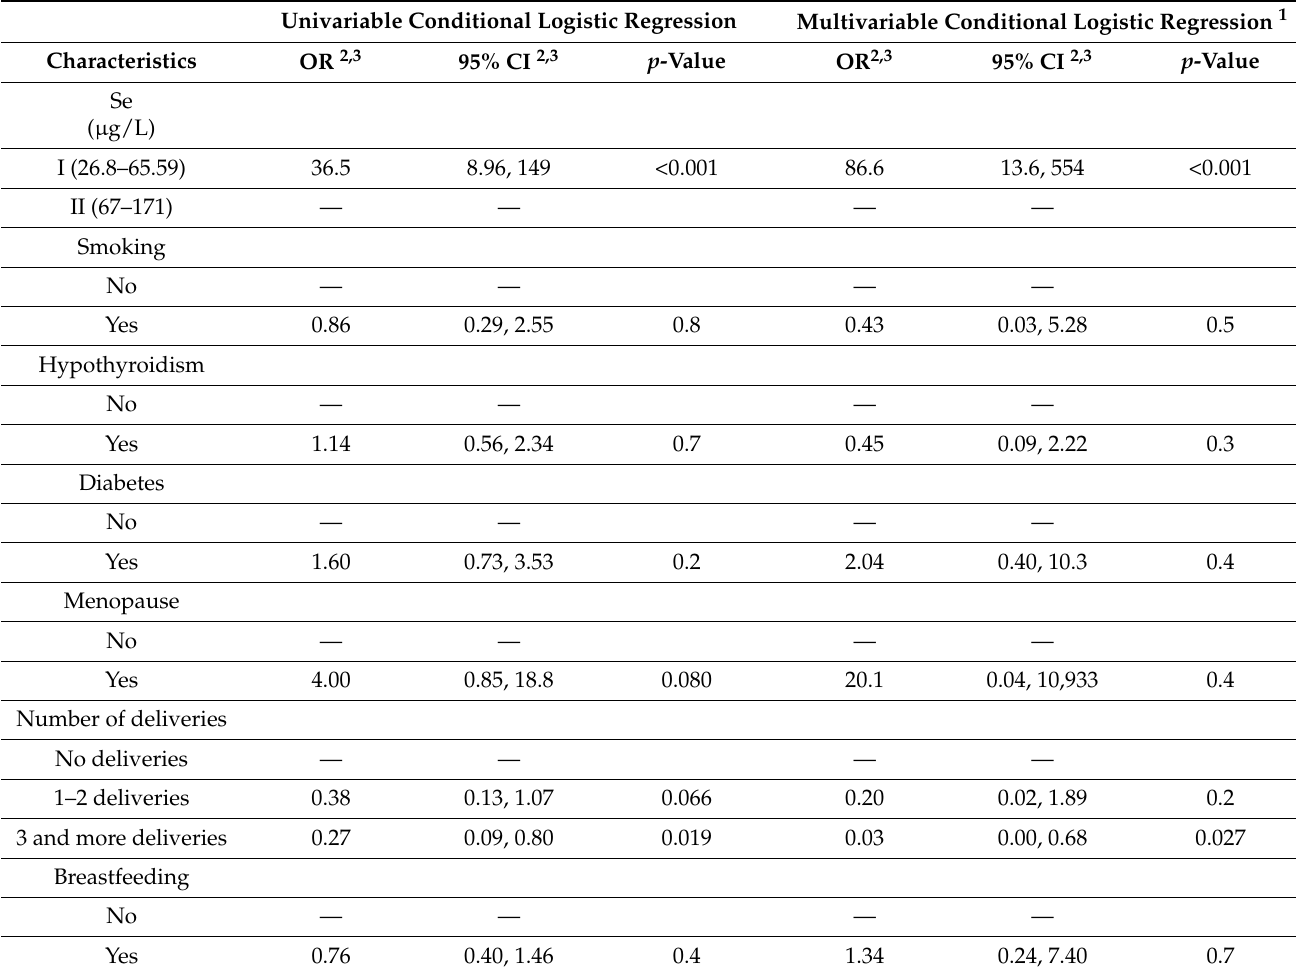
Table 4. Statistical results for the FIGO III–IV subgroup. Univariable Conditional Logistic Regression Multivariable Conditional Logistic Regression